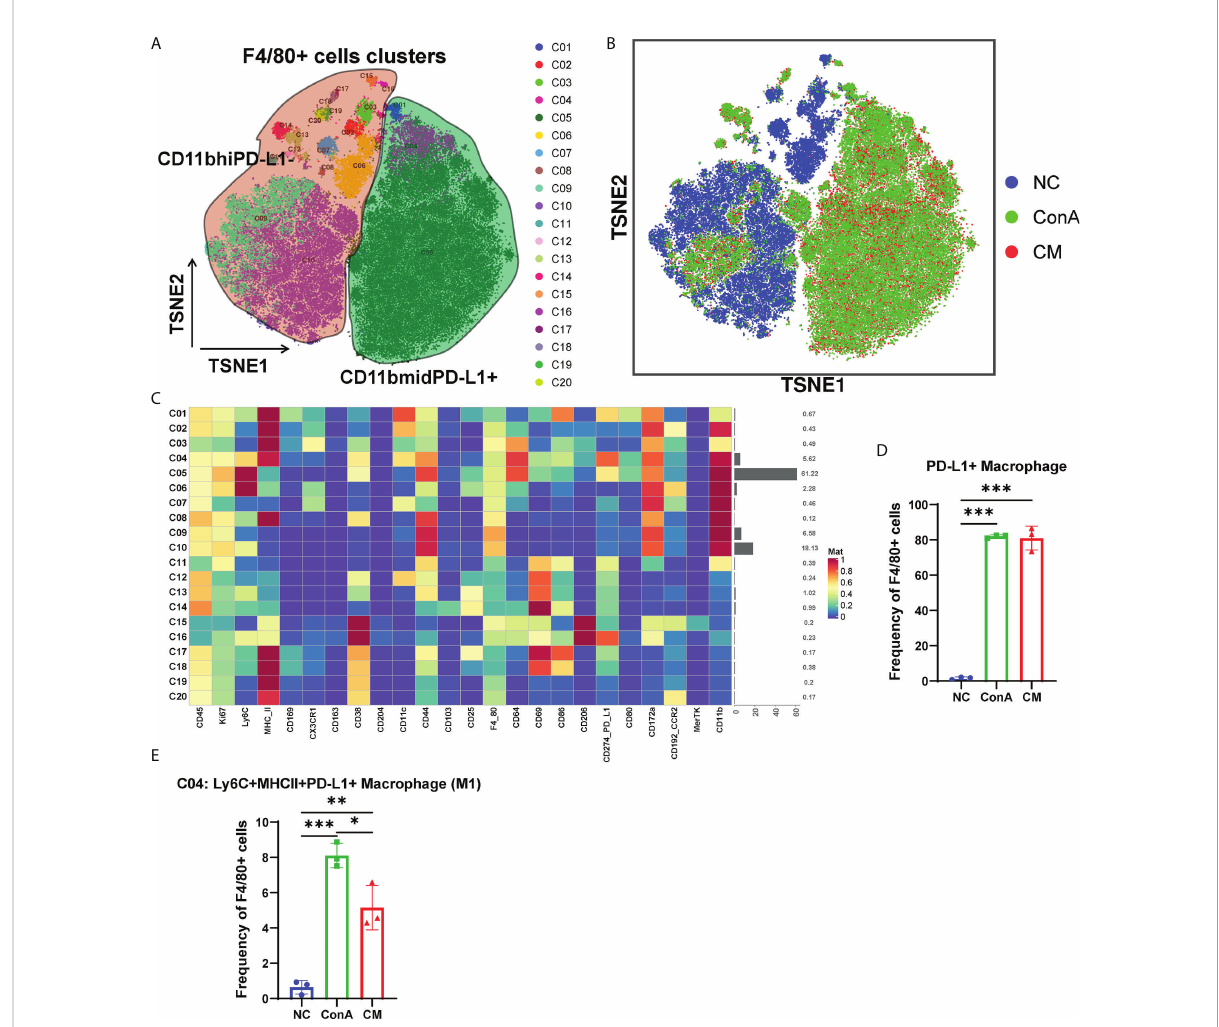
FIGURE 5 Overview of the CyTOF landscape of F4/80 + cells in liver samples. (A) t-SNE map colored by different subgroups. (B) t-SNE map colored by three groups. (C) Heatmaps of cell surface markers expressed in F4/80 + cell subtypes. The proportions of (D) PD-L1 + macrophages and (E) the C04 subtype among the three groups in F4/80 + cells. (n = 3 per group; * p < 0.05, ** p < 0.01, *** p < 0.001). Data are presented as mean ±